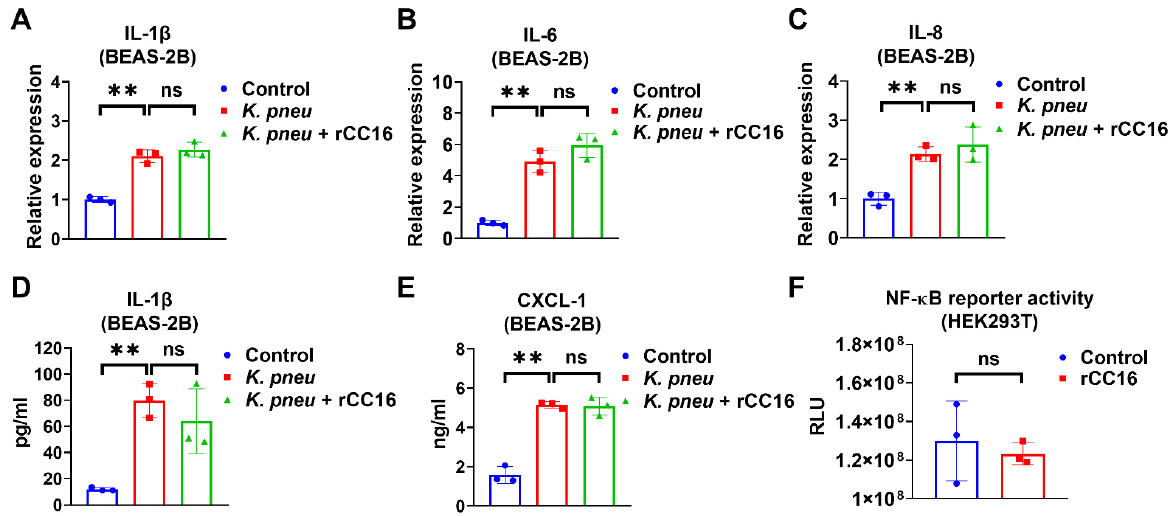
Figure 2. CC16 recombinant protein does not reduce K. pneu- induced inflammation. ( A – E ) BEAS-2B cells were infected with a 1:5 ratio of K. pneu for one hour. BEAS-2B was treated with 50 µg/mL of gentamycin for 48 h with or without 5 µg/mL of CC16 recombinant protein. The mRNA levels of IL-1 β ( A ), IL-6 ( B ), and IL-8 ( C ) were determined by real-time polymerase chain reaction (real-time PCR). The secretions of IL-1 β ( D ) and CXCL-1 ( E ) were measured using ELISA. ( F ) NF- κ B reporter activity was analyzed after treating 200 ng/mL of LPS for 24 h with or without 5 µg/mL of rCC16 treatment. Results represent mean ± SD of 3 independent experiments. ns p > 0.05, ** p < 0.01.